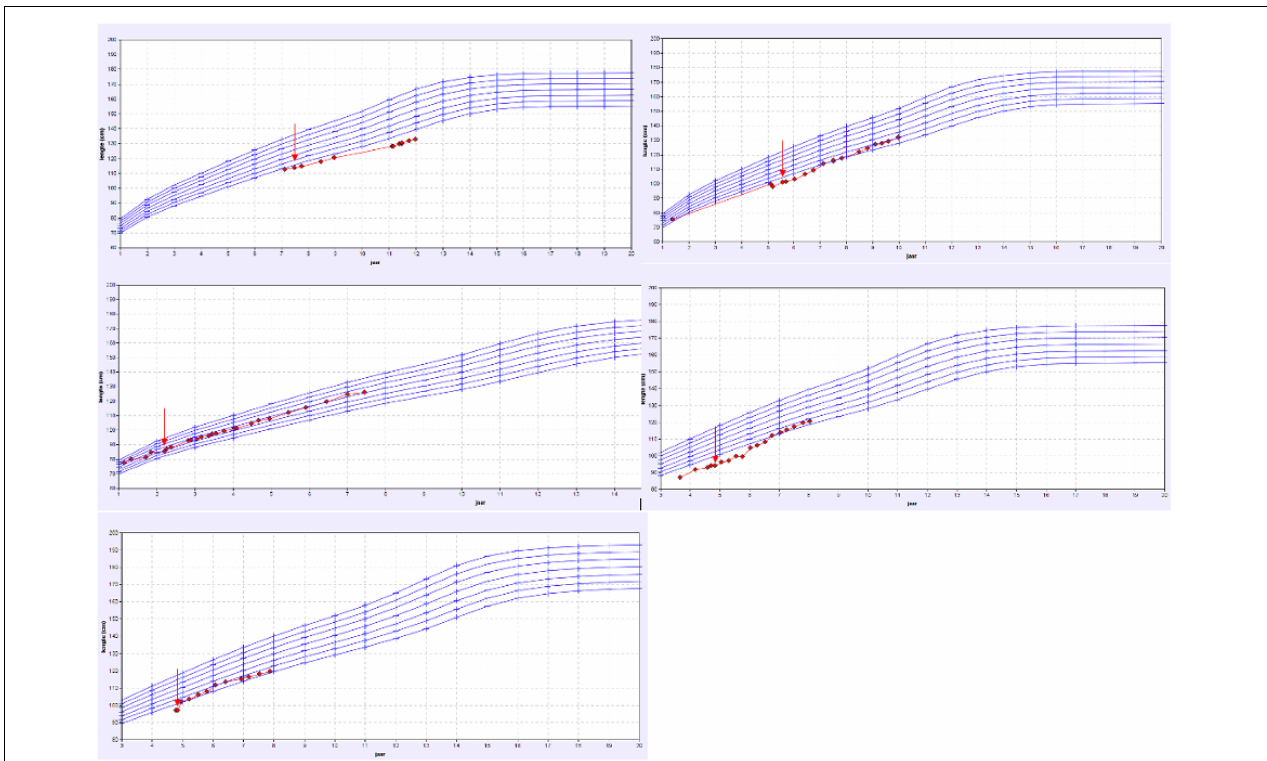
FIGURE 3 | Overview of the growth charts of patients with a proven tubulopathy. X-axis: the age in years and Y-axis: height in cm. The red arrow shows the time point the treatment with specific oral electrolyte supplementation was initiated.